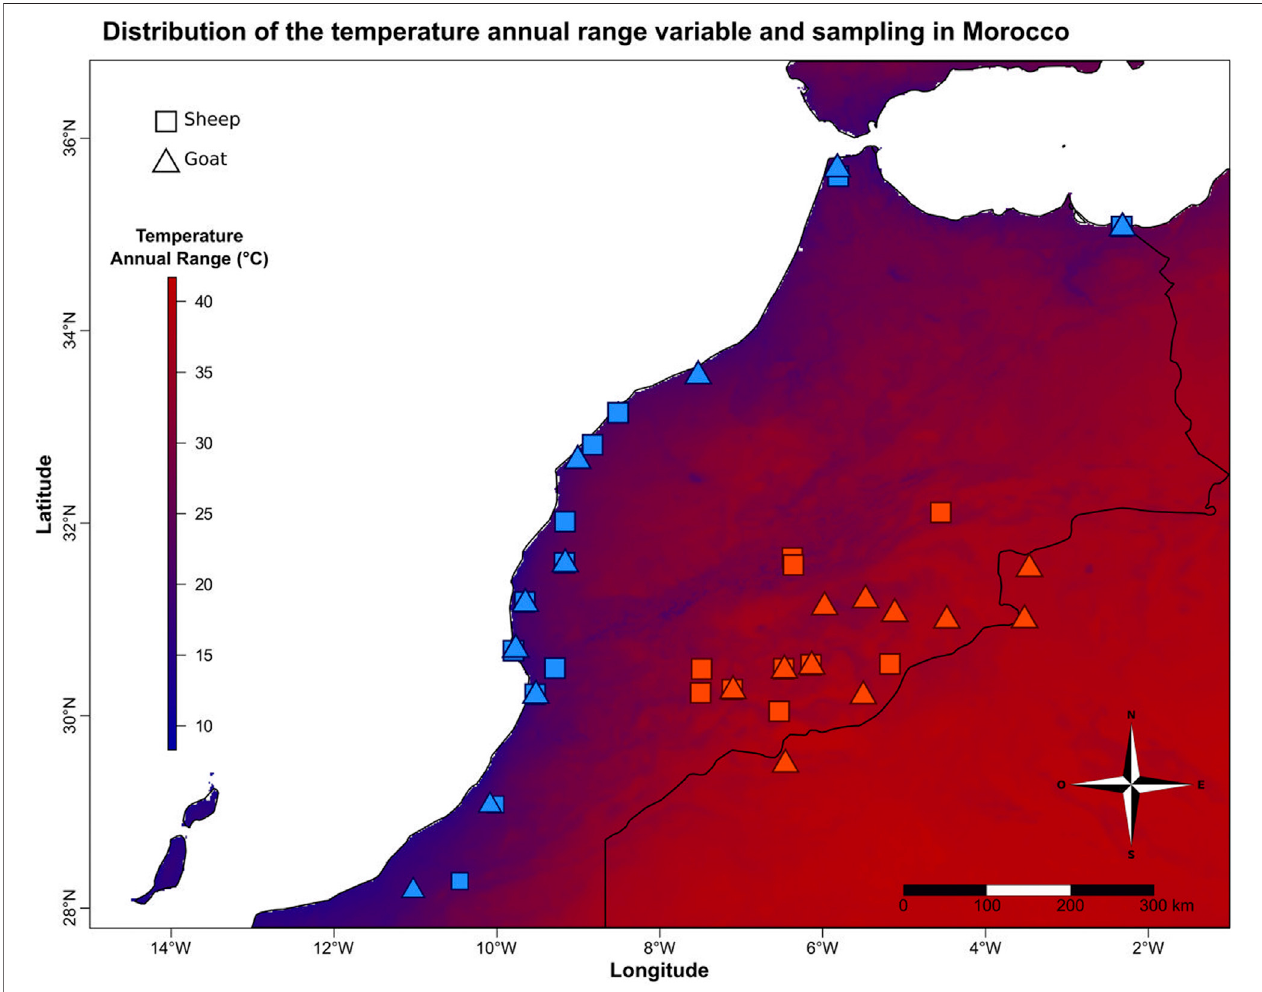
FIGURE 1 | Variation of the annual temperature range and sampling of small ruminants in Morocco. Distribution of sheep and goats sampled at each end of the temperature gradient in Morocco. The color gradient corresponds to the variation of the annual temperature range (BIO7).